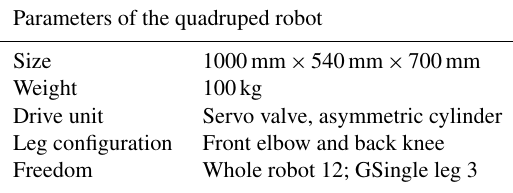
Figure 1. Quadruped robot model. Table 1. Parameters of the quadruped